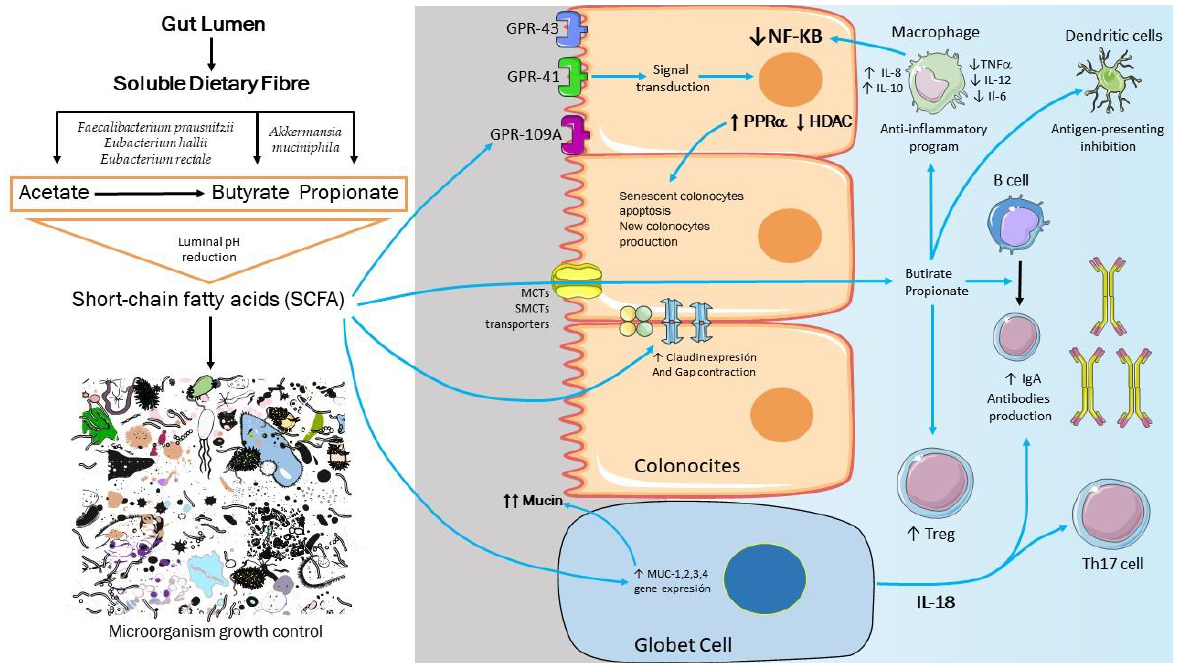
Figure 2. Main effects of short-chain fatty acids (SCFA) on microbiota and epithelium barrier. SCFA protect the intestinal barrier by lowering the levels of TNF α and interleukin (IL)-6, activating the G-protein coupled receptors (GPCR) to participate in PPar α expression increase and the intestinal- mediated inflammatory and immune response by suppressing histone deacetylase (HDAC) and downregulating the expression of pro-inflammatory cytokines. Additionally, SCFA upregulates the gene expression of mucin family genes (MUC1 – 4) in the intestine, and the protons generated by SCFA dissociation produce an osmotic pressure imbalance in the bacteria. Furthermore, SCFA inhibits bacterial multiplication by interfering with DNA and protein synthesis.